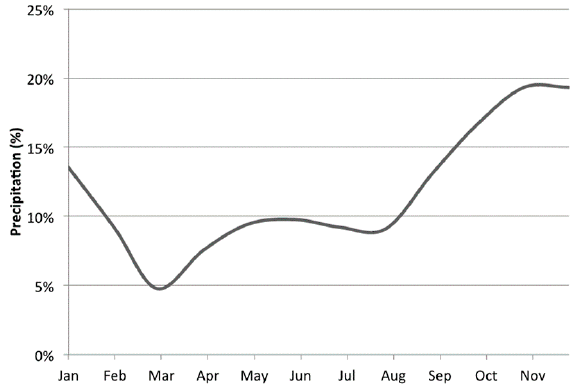
Figure 4. Smoothed monthly change in the mean precipitation of the 18 first-order stations from 1949–2016.